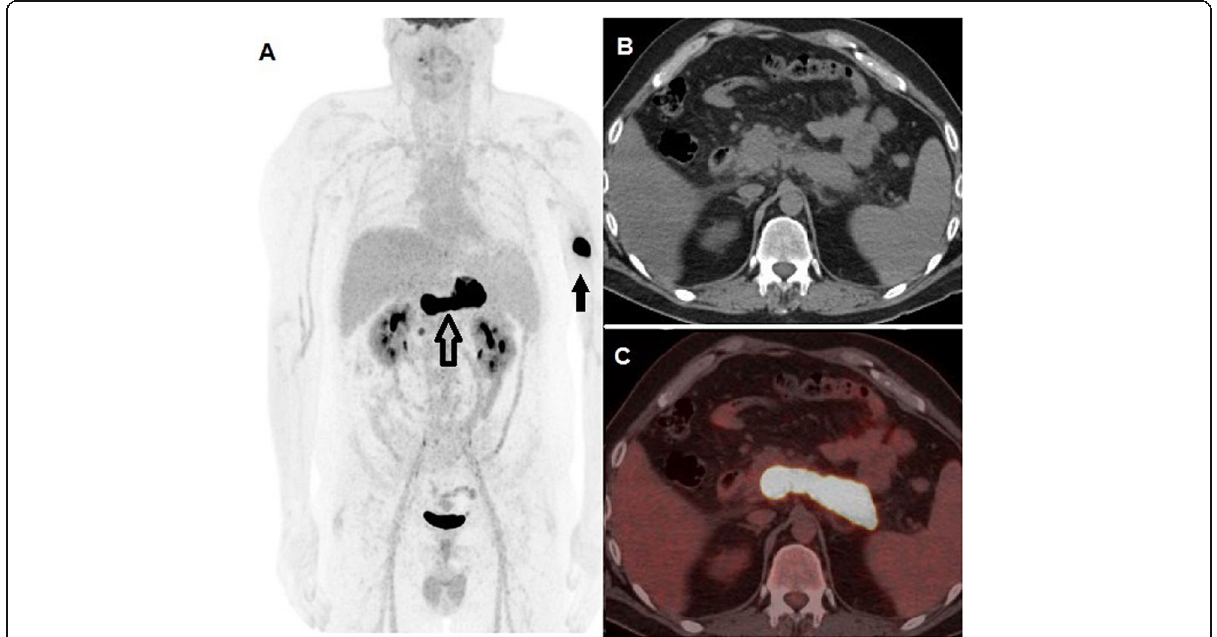
Fig. 1 Whole body 18 F-FDG PET/CT ( A ) demonstrated extremely increased tracer incorporation in the cutaneous/subcutaneous metastasis in the left arm (black arrow) with maximum standardized uptake value (SUVmax) of 67.3 and diffuse and intense 18 F-FDG uptake in the whole pancreas (SUVmax 99.3, black bordered arrow), which resulted significantly enlarged at the corresponding CT ( B ) and fused PET/CT ( C ) axial slices